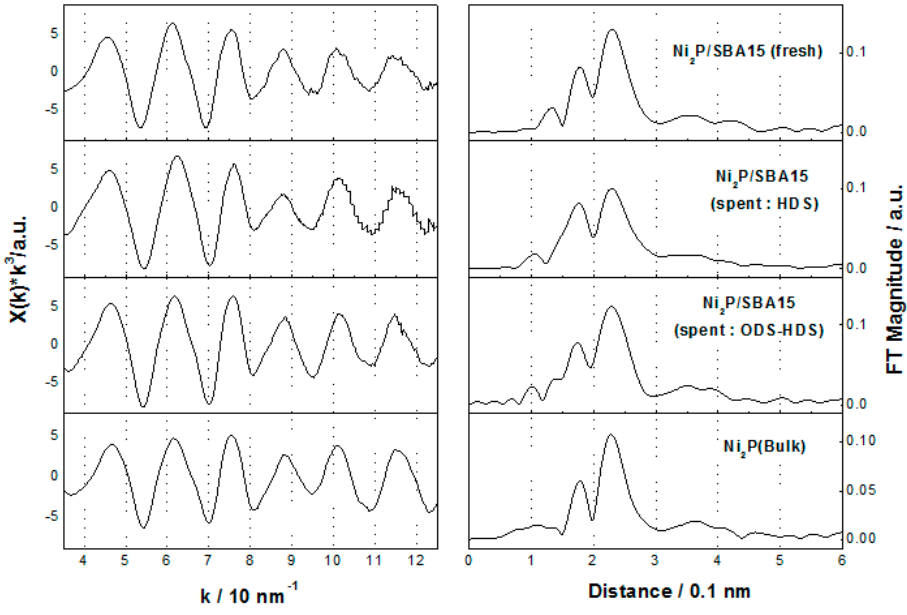
Figure 3. Ni K ‐ edge EXAFS spectra of fresh and spent catalyst samples. Figure 3. Ni K-edge EXAFS spectra of fresh and spent catalyst